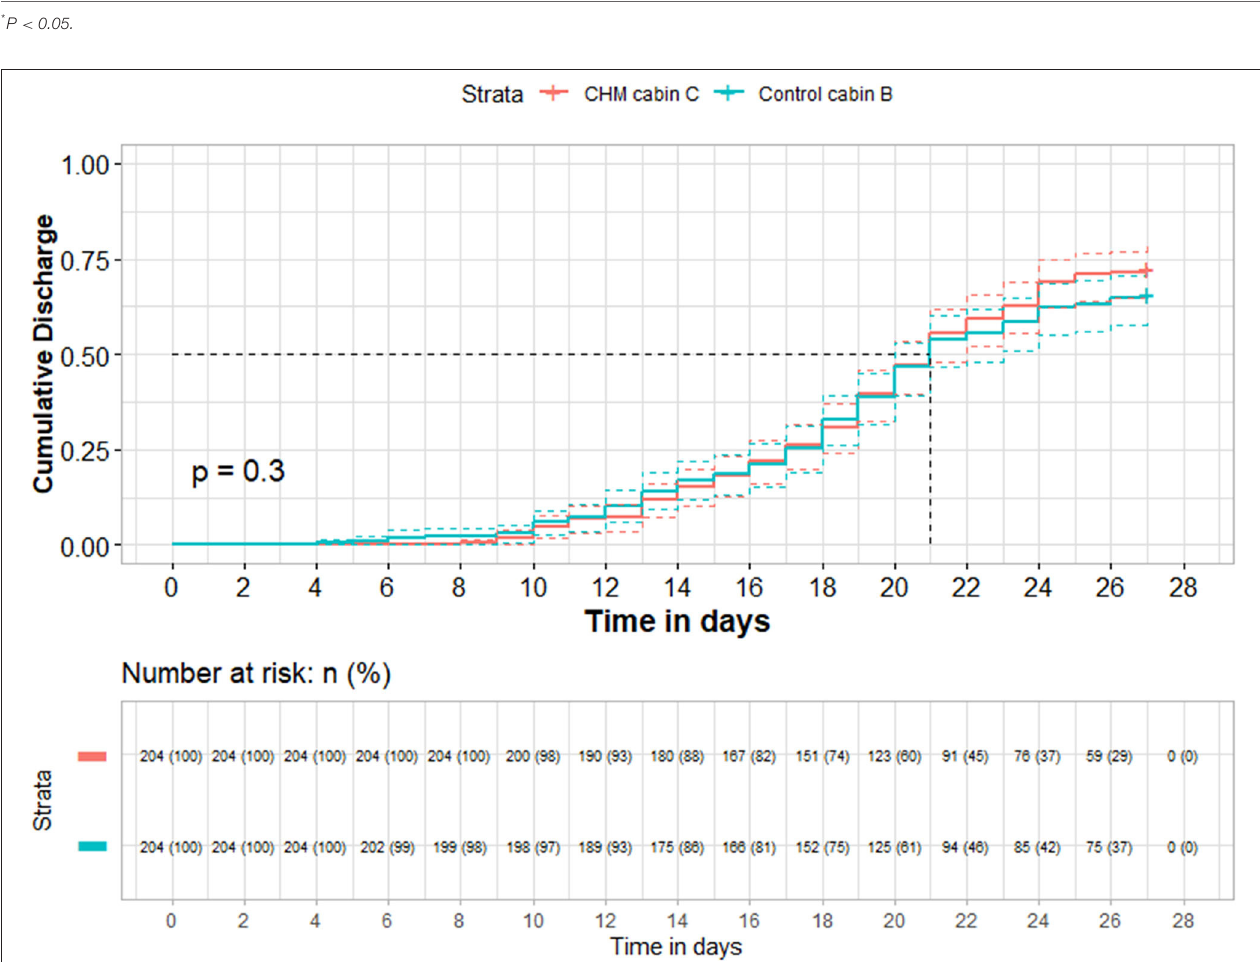
FIGURE 2 | Cumulative incidence curves of discharge. +: Contained right censoring participants caused by death, worsening and transferring due to gradual closure of FangCang